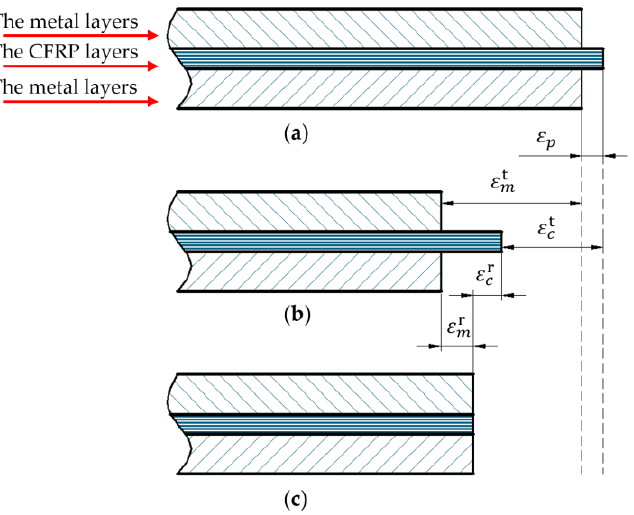
Figure 6. Schematic of thermal residual strains: ( a ) no strain state; ( b ) ideal state; ( c ) final state.